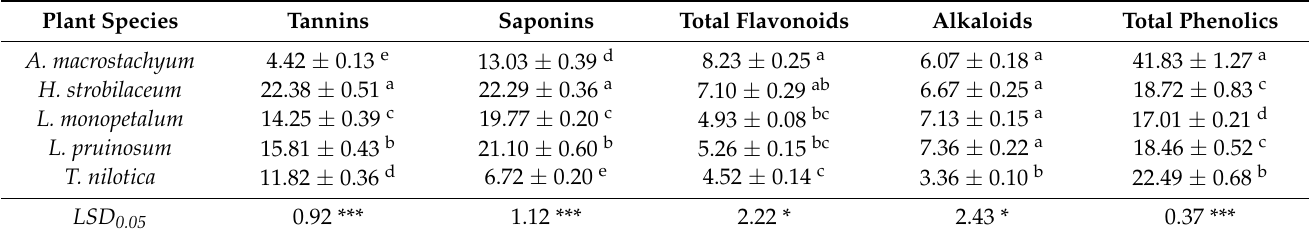
Table 3. Bioactive composition (mg g − 1 DW) of the five studied